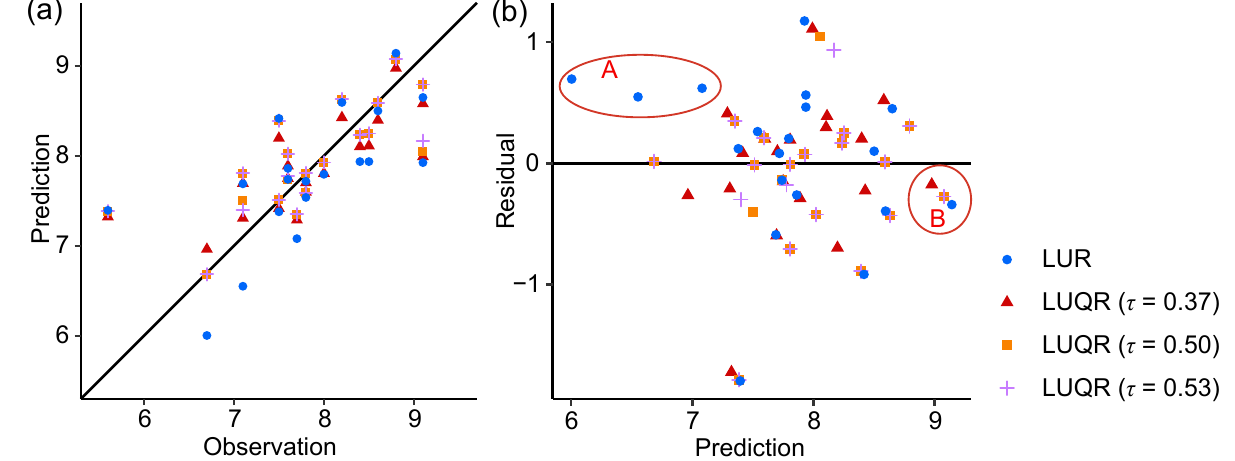
Figure 5. Comparison of LOOCV results between LUR and LUQR models: relationship between observations and predictions of PM 2.5 concentrations in LOOCV ( a ) and relationship between predic- tions and residuals of PM 2.5 concentrations in LOOCV ( b